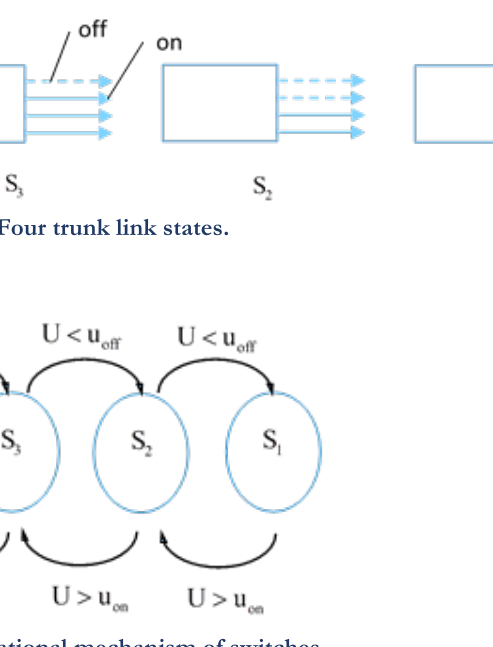
Fig. 2. The operational mechanism of